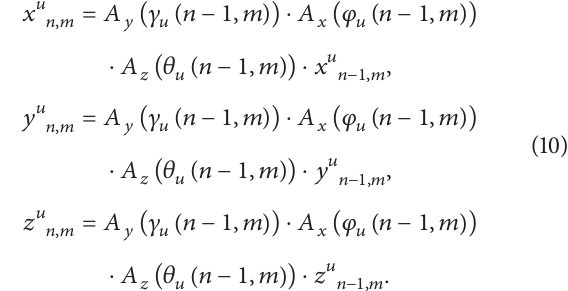
Figure 6: Schematic diagram of a smart FBG